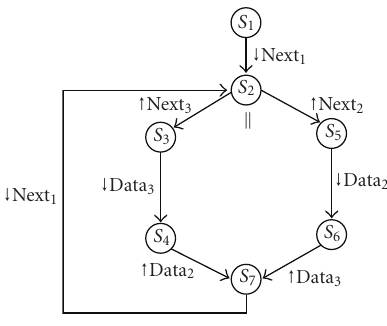
Figure 2: A service specification